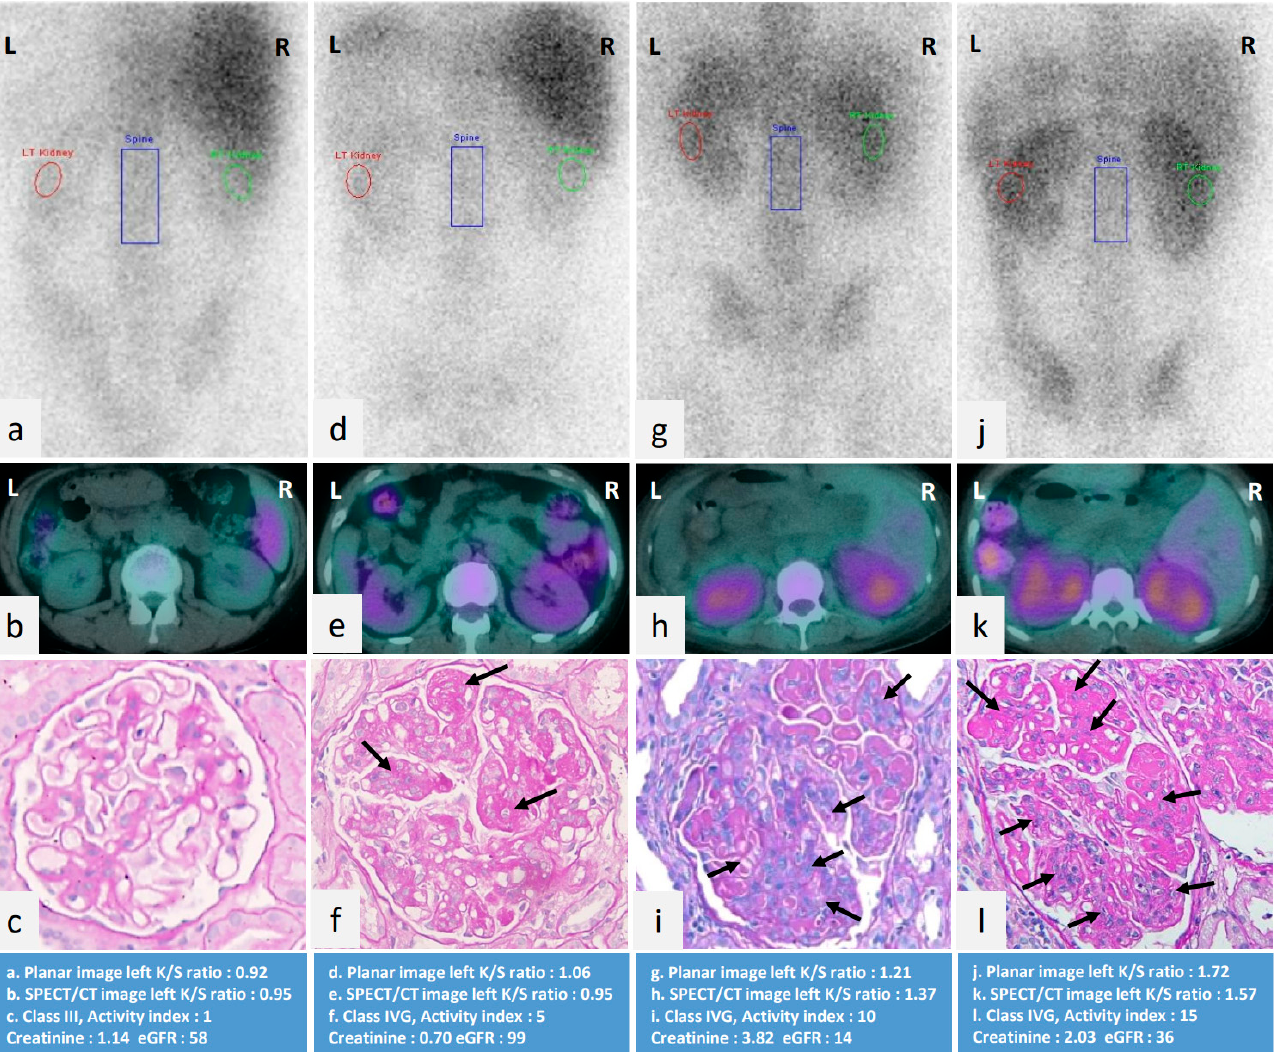
Figure 2. Renal gallium planar view ( a , d , g , j ) and SPECT/CT ( b , e , h , k ) images of four different LN patients from low to high activity index scoring in renal histopathology ( c , f , i , l ). ( a – c ) A 34-year-old LN female patient with activity index 1 in pathology, left K/S ratio 0.92 in gallium planar image; ( d , e ) A 40-year-old LN female patient with activity score 5 in pathology, left K/S ratio 1.06 in gallium planar image; ( g – i ) A 41-year-old LN female patient with activity score 10 in pathology, left K/S ratio 1.21 in gallium planar image; ( j – l ) A 14-year-old LN female patient with activity score 15 in pathology, left K/S ratio 1.72 in gallium planar image. This figure revealed that a trend of a higher degree of gallium uptake calculated by left K/S ratio, the greater degree of activity index score and endocapillary hypercellularity (arrows) L: left side; R: right side; SPECT/CT: single photon emission computed tomography; LN: lupus nephritis; K/S ratio: kidney/spine ratio.